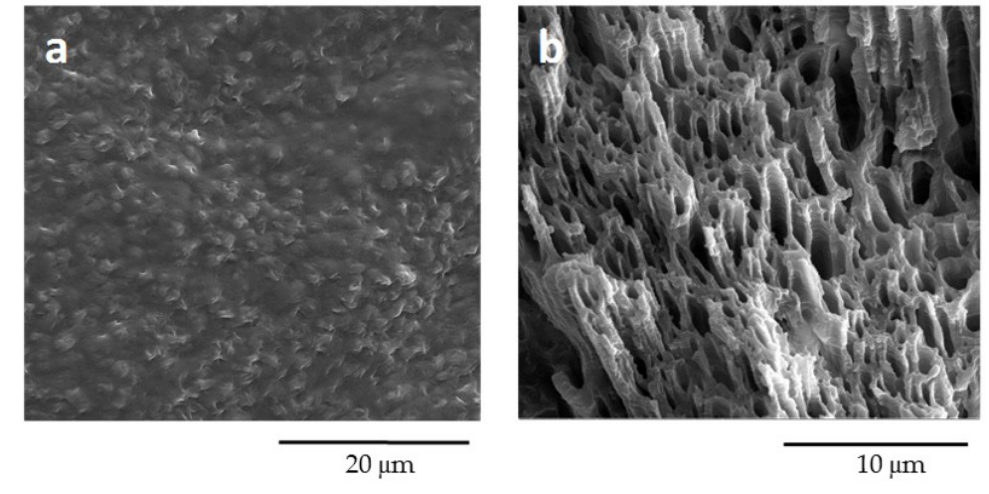
Figure 7. SEM images of PBS50 / PBAT50: ( a ) film surface and ( b ) cryogenic fracture surface after PBAT removal by etching in THF.